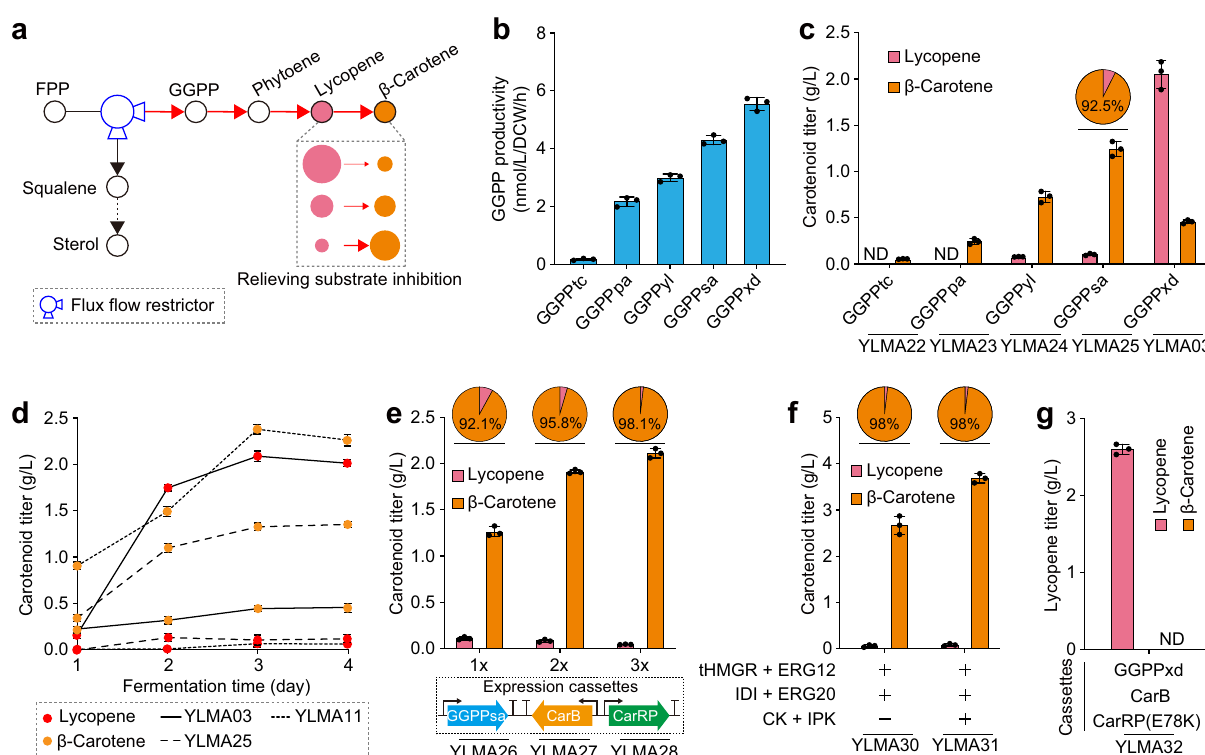
Fig. 3 A GGPPS-mediated metabolic fl ow restrictor effectively relieves substrate inhibition. a A GGPPS-mediated metabolic fl ow restrictor can vary the amount of fl ux through the carotenoid synthesis pathway, thus regulating lycopene formation rates. b Changes in GGPPS activity can be achieved by expressing enzymes from different organisms in Y. lipolytica , as indicated by the varying in vivo GGPP synthesis rate. In these experiments, a po1f background strain with no modi fi cations other than GGPPS expression was used. c Compared to the strain expressing GGPPxd, other strains housing lower-activity GGPPSs mitigated the substrate-inhibition effect of lycopene cyclase. The slower formation rates of lycopene prevented its accumulation and hence nearly all lycopene was converted into β -carotene. ND, not detected. d Fermentation time courses indicated that a balanced pathway with the attenuated GGPPsa (YLMA25) led to minimal lycopene build-up throughout the experiment, consistent with YLMA11, which contained the Y27R variant of CarRP. On the contrary, rapid lycopene accumulation was observed in the strain with the exceedingly ef fi cient GGPPxd (YLMA03). e Gene expression cassettes containing the balanced pathway (GGPPsa, CarB, and CarRP) was sequentially introduced into the po1f-T strain for β -carotene production. With higher copy numbers, β -carotene titers increased up to 2.13 g/L, and the selectivity of β -carotene was maximized. f Overexpressing MVA and IUP further improved β -carotene synthesis while maintaining its high selectivity. g Using the exceedingly ef fi cient GGPPxd to deliberately trigger substrate inhibition, along with a mutated CarRP(E78K), a lycopene-producing strain was constructed, which reached a titer of 2.62 g/L. ND, not detected. For b to g , The average and s.d. of three biologically independent experiments are shown. Source data are provided as a Source Data fi